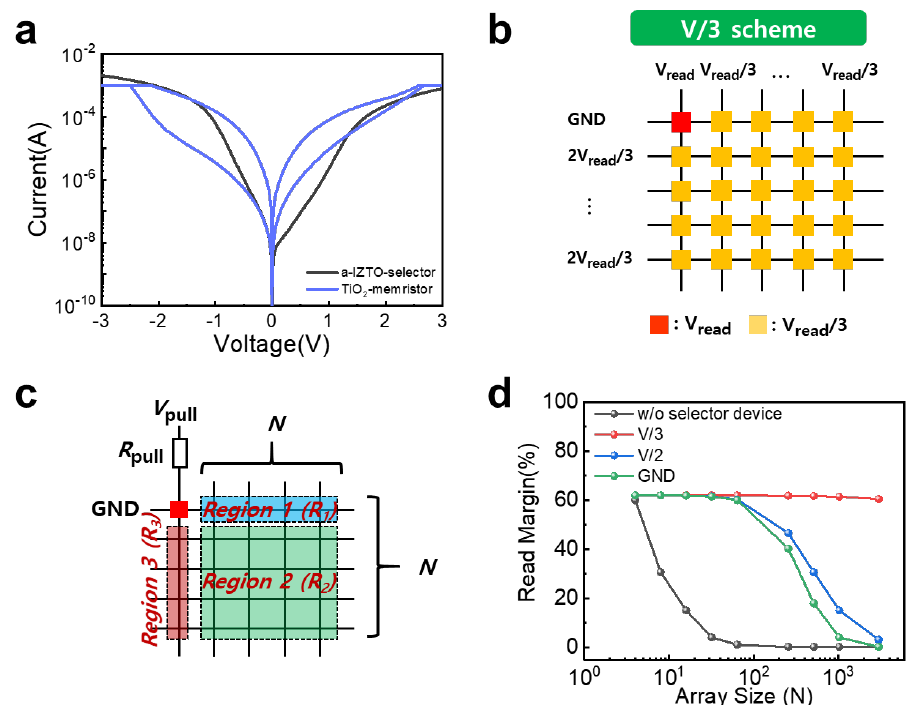
Figure 4. ( a ) I-V characteristics of TiO 2 -memristor and a-ITZO-selector device. ( b ) V/3 scheme for operation of the memristor crossbar array. ( c ) Equivalent circuit of an N X N memristor crossbar array to calculate the reading margin. ( d ) Calculated reading margin according to ground, V/2, and V/3 schemes as a function of array size.